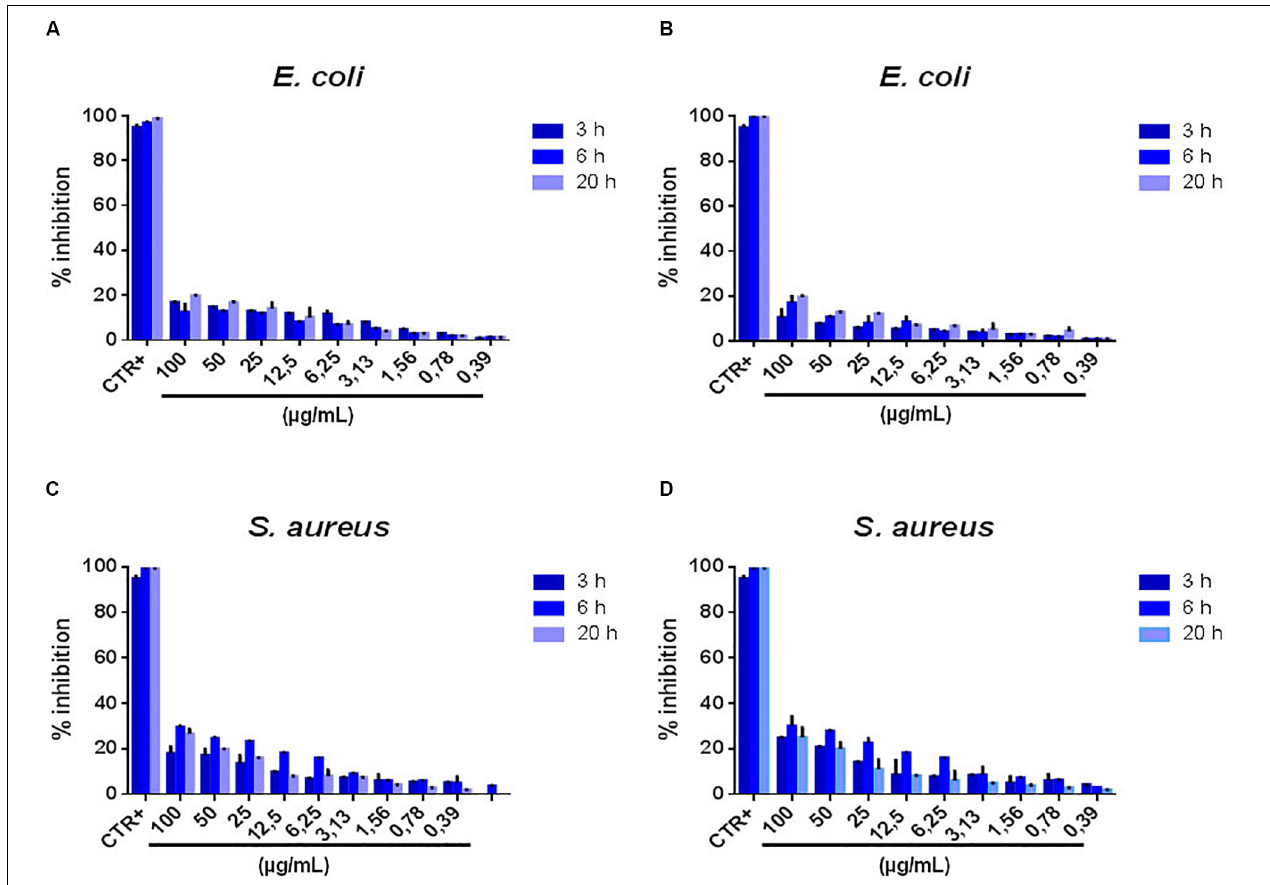
FIGURE 4 | Percentage of bacterial growth inhibition after treatment with GO NSs. Panel (A,B) Percentage inhibition E. coli at 3-6-20 h of incubation with GO NSs (600 µ g/mL & 1400 µ g/mL). Panel (C,D) Percentage inhibition S. aureus at 3-6-20 h of incubation with GO NSs at same concentration. Ampicillin and vancomycin represented the positive controls for E. coli and S. aureus , respectively. The negative controls were consisted of deionized water. The data statistical error is standard deviation of three independent experiments. P -value is less than